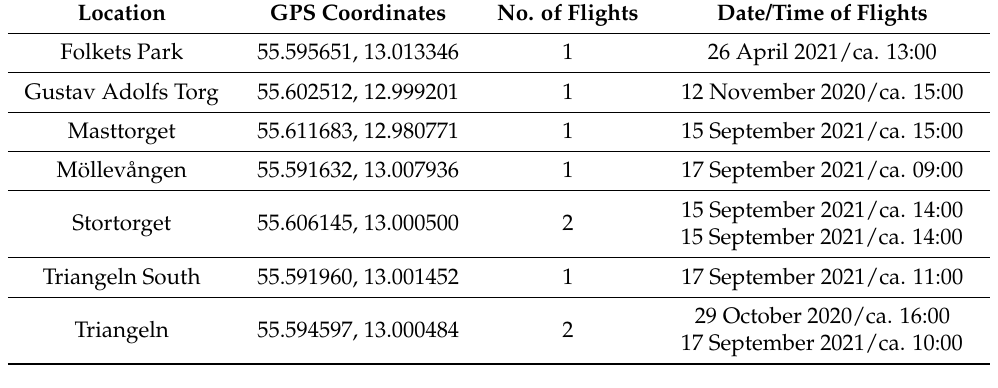
Table 1. The seven locations selected in Malmö and the number of flights made at each site.